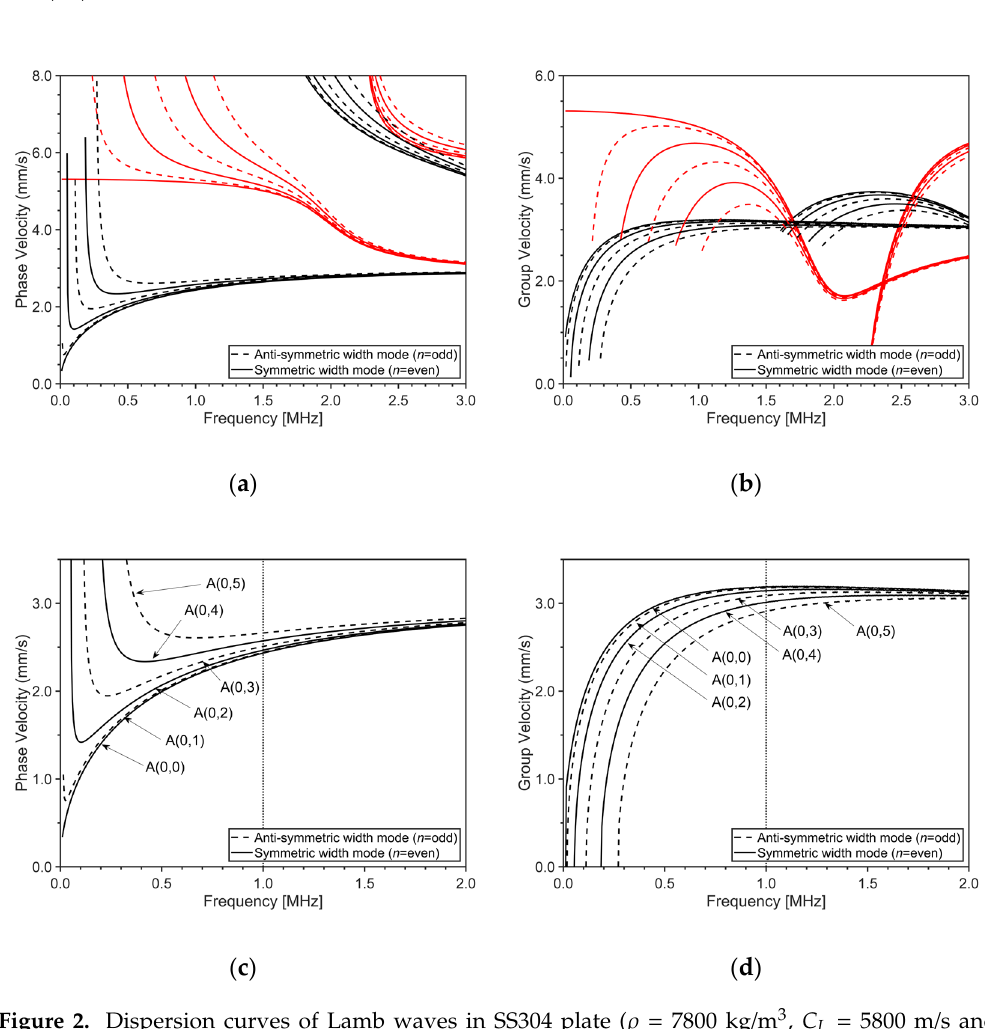
=7,800 kg/m 3 , =5,800 m/s and =3,160 𝝆𝝆 𝑪𝑪 𝑳𝑳 𝑪𝑪 𝑺𝑺